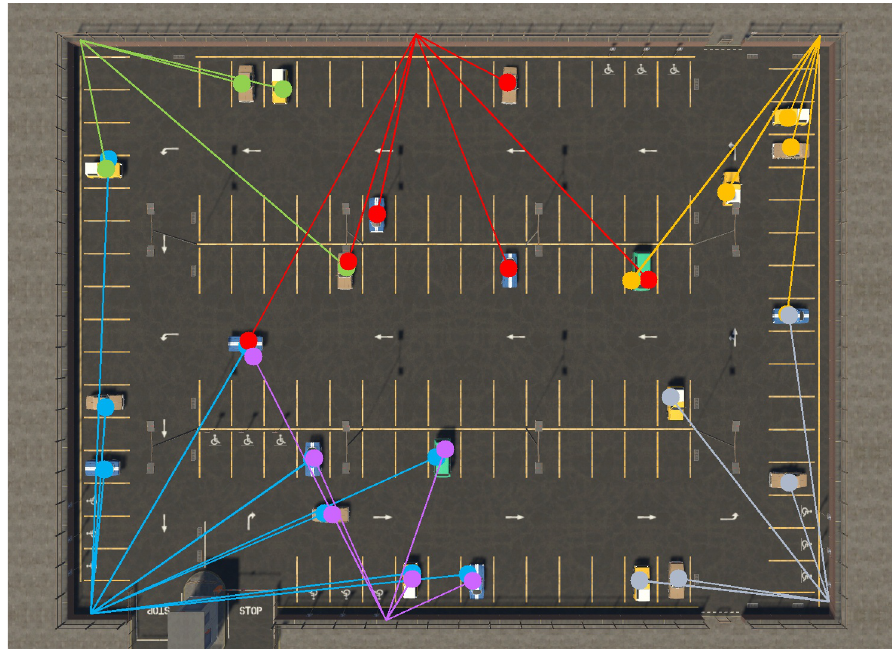
Figure 12. Vehicle location results. The color of the location result indicates the camera that detects this